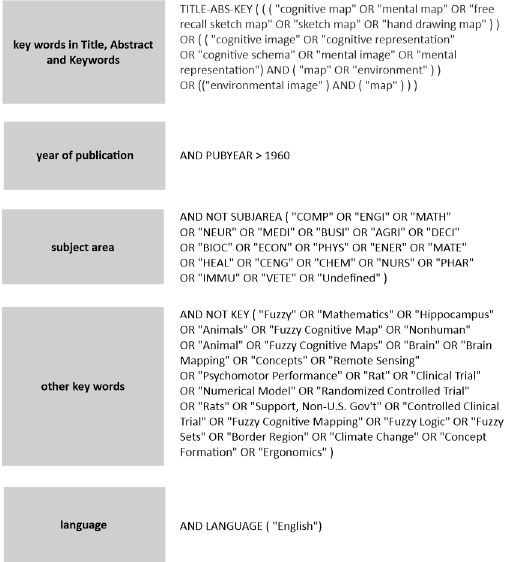
3. Figure 3. The command used to search for articles in the SCOPUS